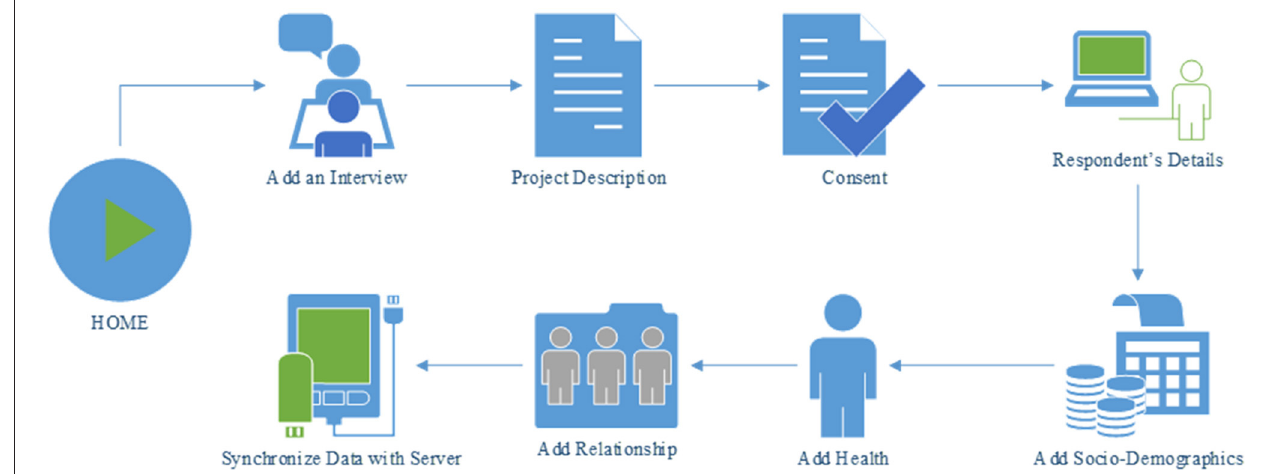
FIGURE 2 | A typical workflow of the interview process using TRHC